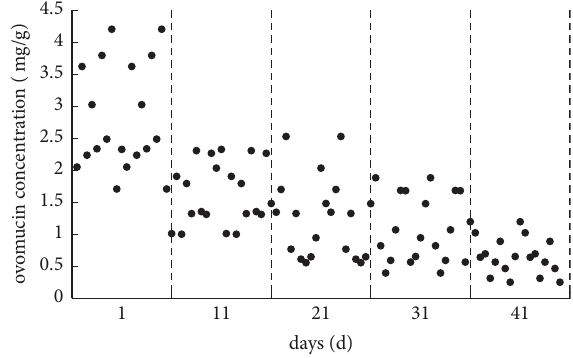
Figure 2: Changes in ovomucin concentration during